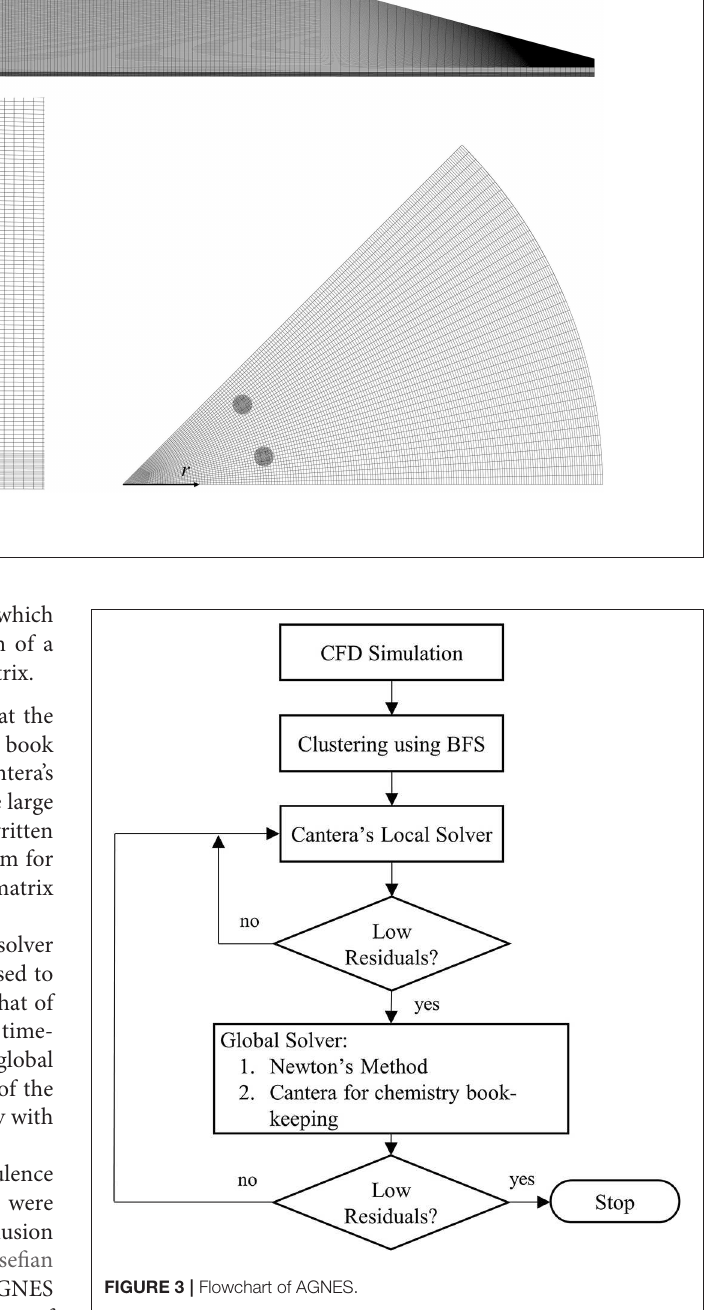
FIGURE 3 | Flowchart of